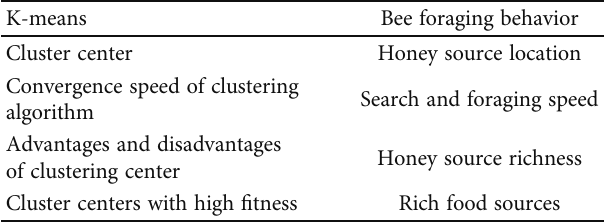
Table 1: Comparison of bee colony optimization and K-means. K-means Bee foraging behavior Cluster